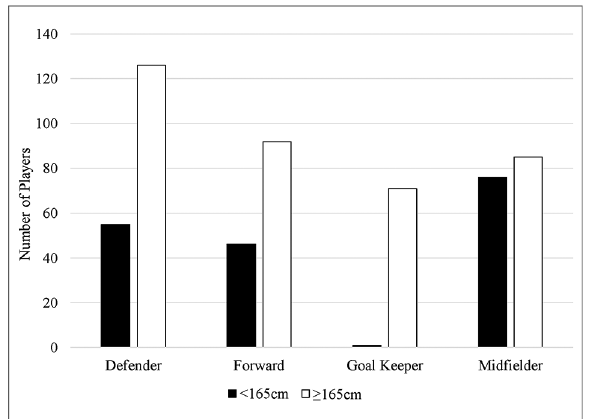
FIGURE 2 Visual representation of players by position and stature. Black bars indicate number of players <165 cm. White bars indicate number of players ≥ 165